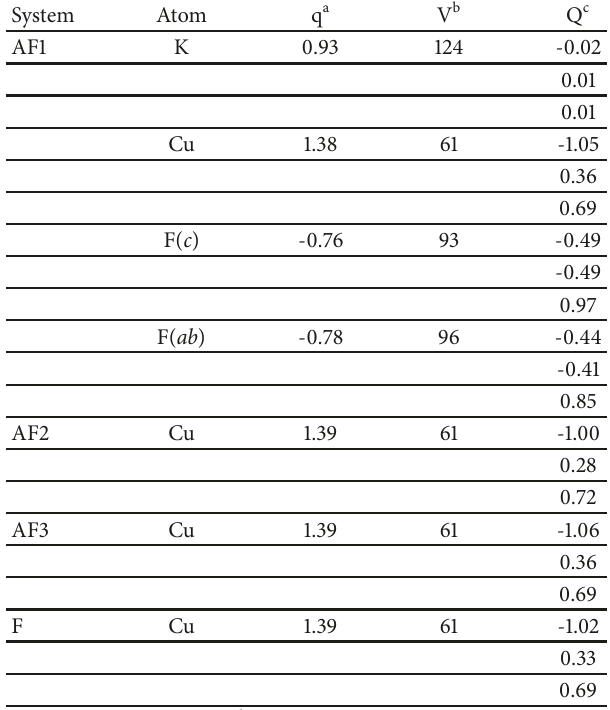
Table 3: Atomic properties in pure KCuF 3 computed with the QTAIM